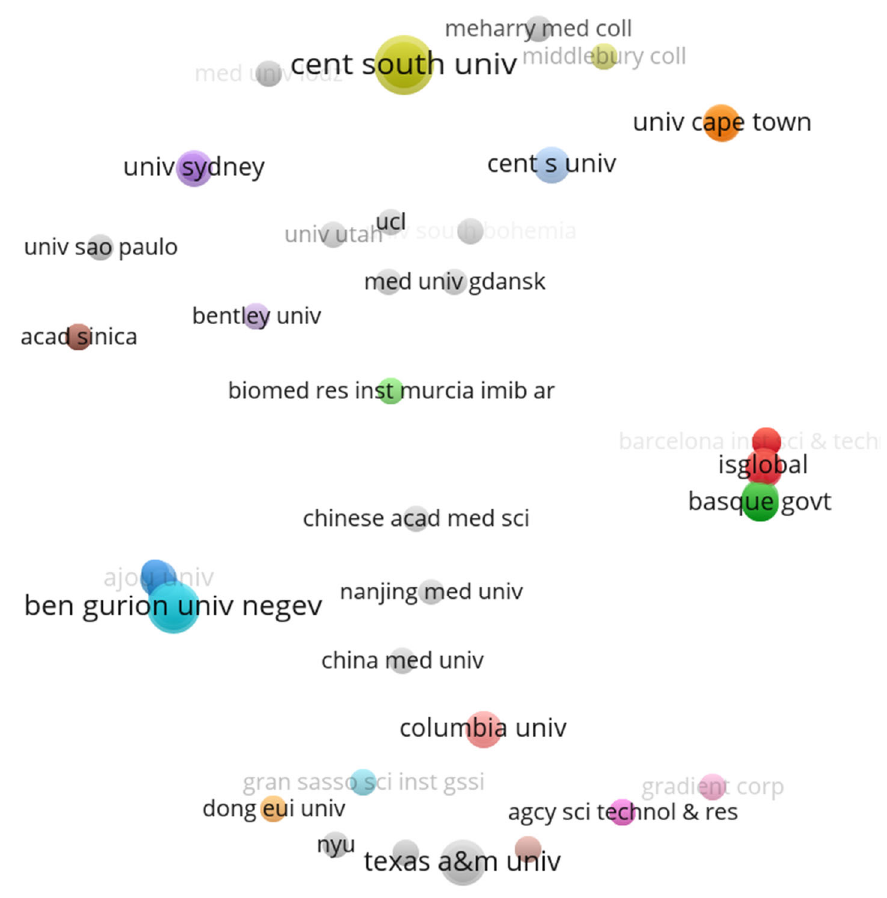
Figure 7. Institution co ‐ authorship map for prenatal exposure to air pollution publications.